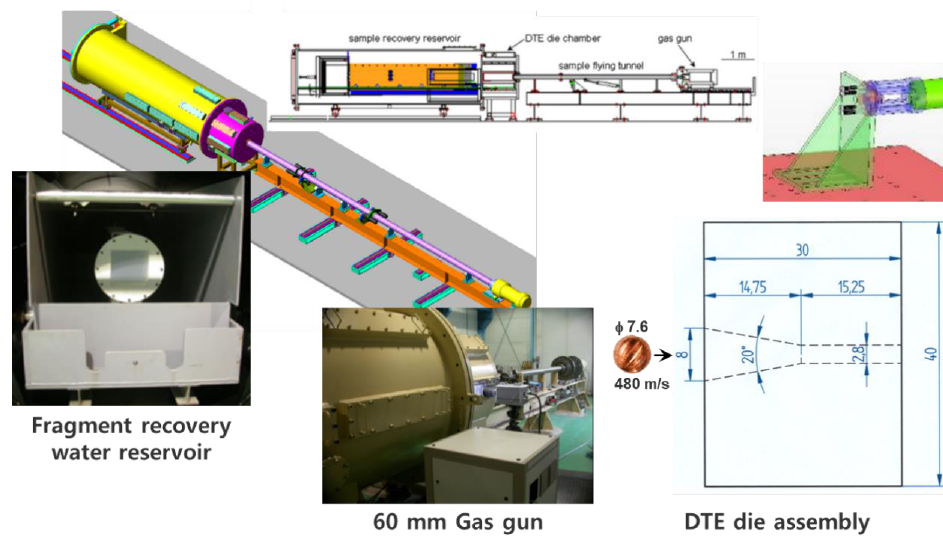
Figure 2. A scheme of the present DTE facility with an “all - vacuum gas gun”, consisting of the gas gun, sample flying tunnel, DTE die assembly, and fragment recovery water reservoir station [5,9].